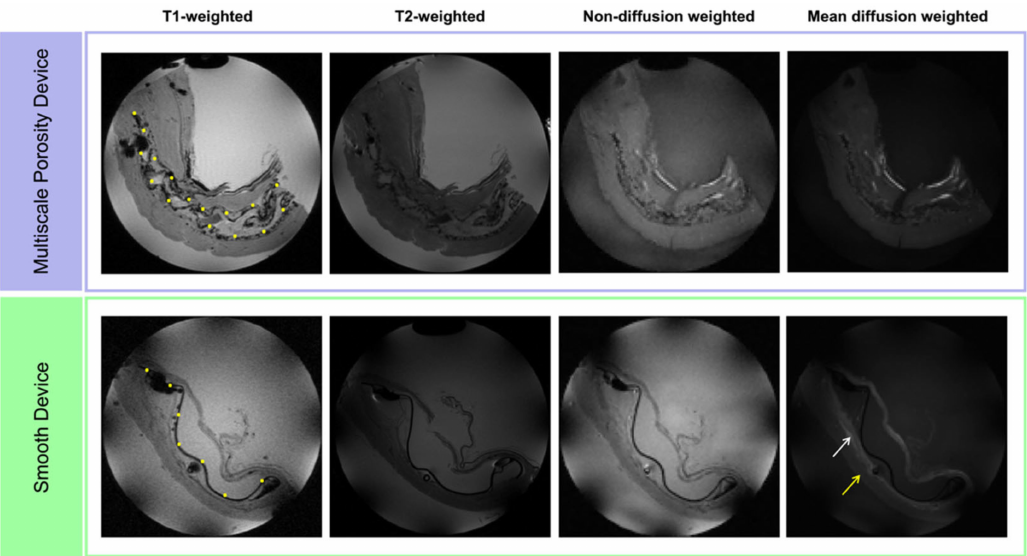
Figure 2. Multi-contrast MRI images of both multiscale porosity and smooth devices. T1- and T2-weighted and non-diffusion weighted (b = 0 s/mm 2 ) images showed little contrast within the samples, while the mean diffusion weighted images (b = 800 s/mm 2 , 32 directions) show contrast between the tissue around the smooth device (white arrow) and the more distal tissue (yellow arrow). Representative slices are shown, yellow dots mark the device